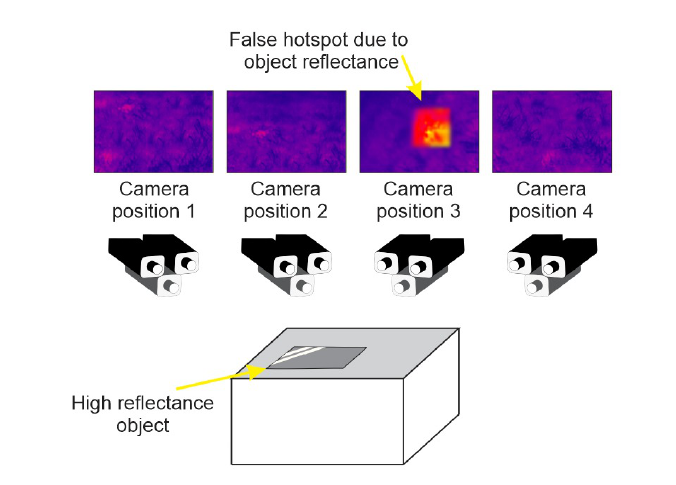
Figure 4. Algorithm to recognize false measurements